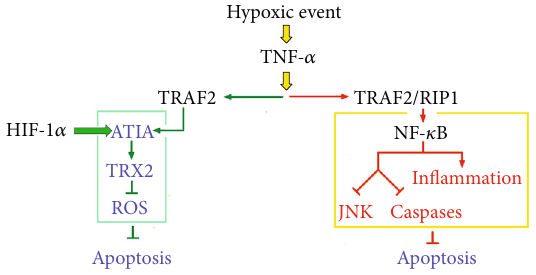
Figure 2: Schematic representation of ATIA as the proposed in fl ammation and hypoxia